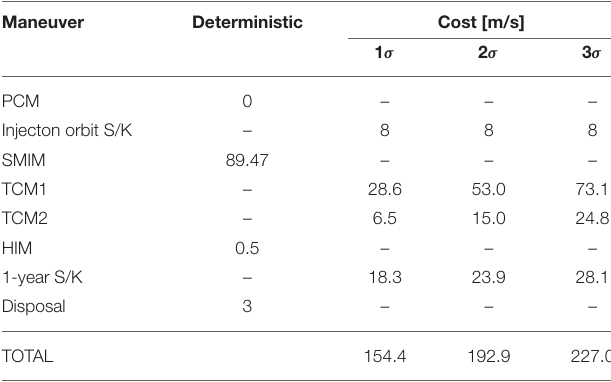
TABLE 12 | Mission 1 v budgets for LUMIO operative